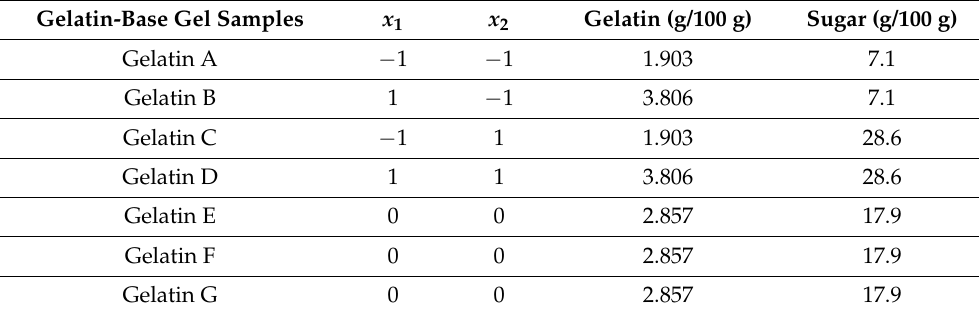
Table 1. Level of variables of experimental